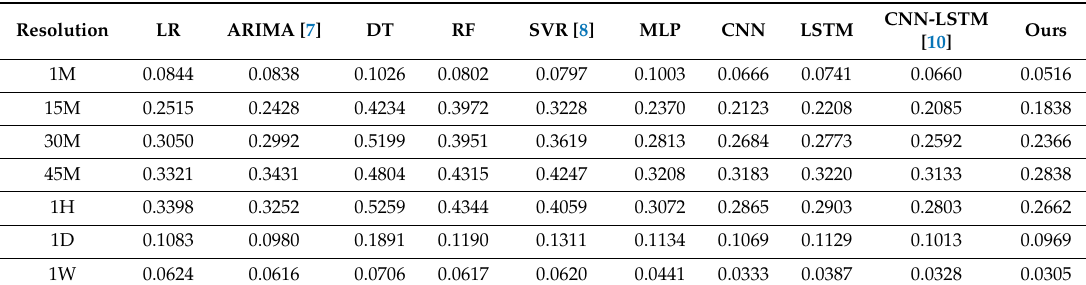
Figure 7. Comparison of MSEs by the time lag parameter 𝝎 4.3. Effects of Multi-Headed Attention For a thorough comparison, in addition to the neural networks proposed in previous works for energy prediction, we implement four additional neural networks and compared the prediction errors in Table 5. The scalability of the multi-headed attention can be evaluated by improving the different neural network architectures. It can be seen that the multi-headed attention improves the